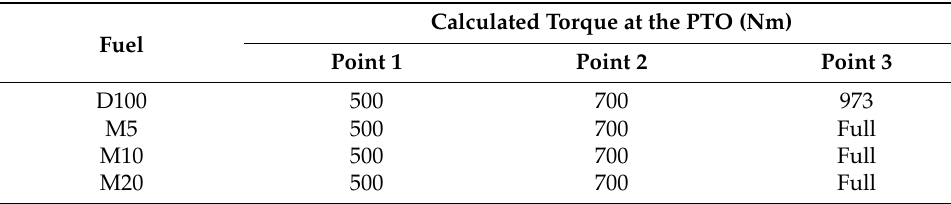
Table 7. Brake torque, calculated for individual measurement points. Calculated Torque at the PTO (Nm) Fuel Point 1 Point 2 Point 3 D100 500